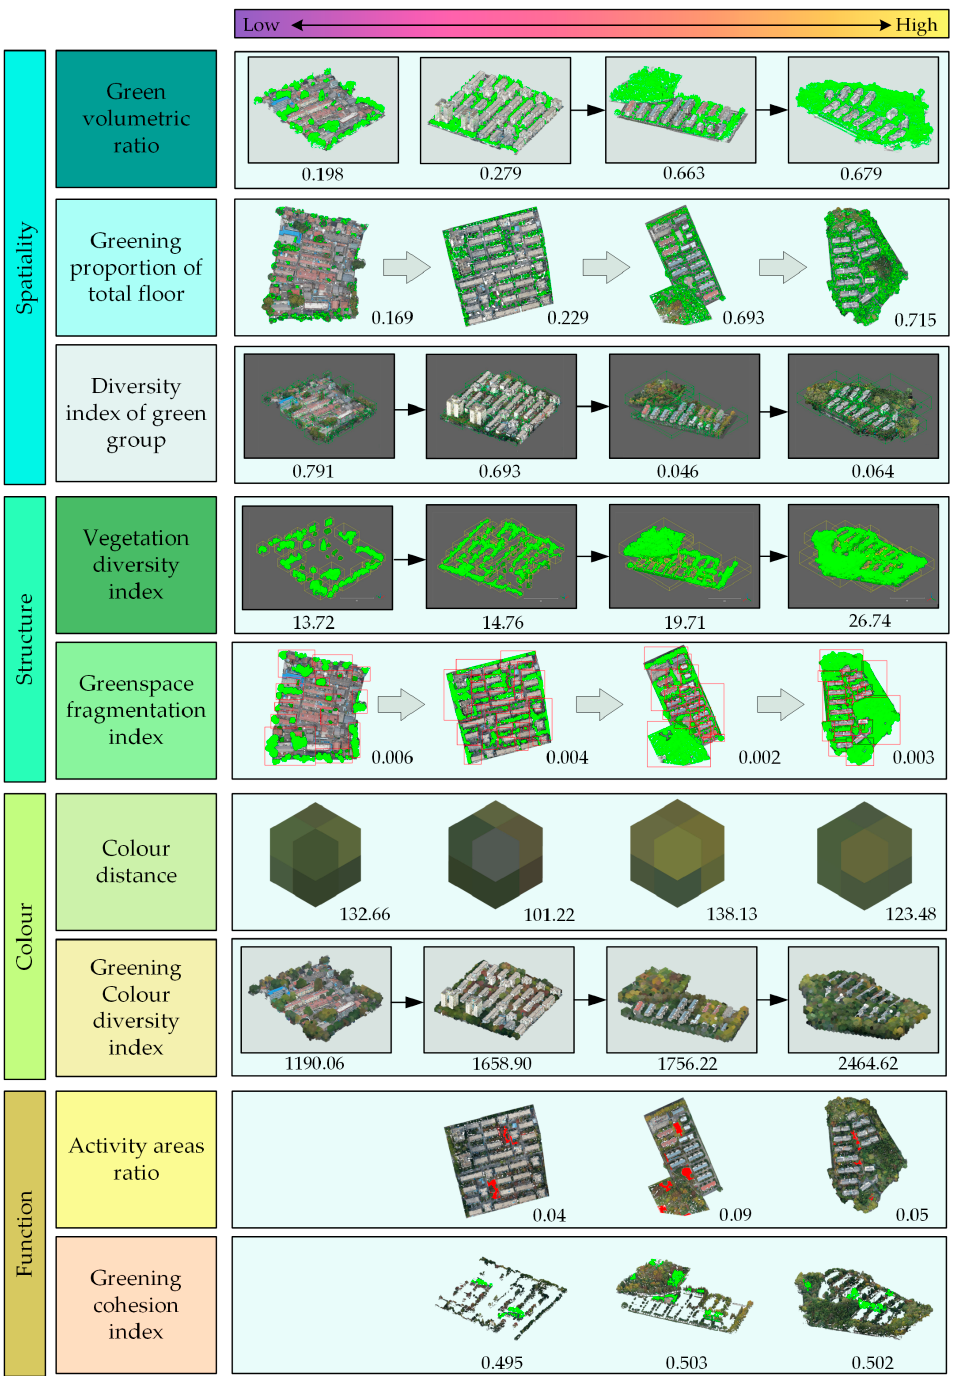
Figure 6. Validation results for the 3-D metrics in the four study areas. The highlighted green (red) areas in the picture are the vegetation (ground) areas for the indicator analysis. Metrics values are shown below the images based on the calculations (Table 3). A lateral view of the FGVR result has been added in the Appendix A for improved clarity.